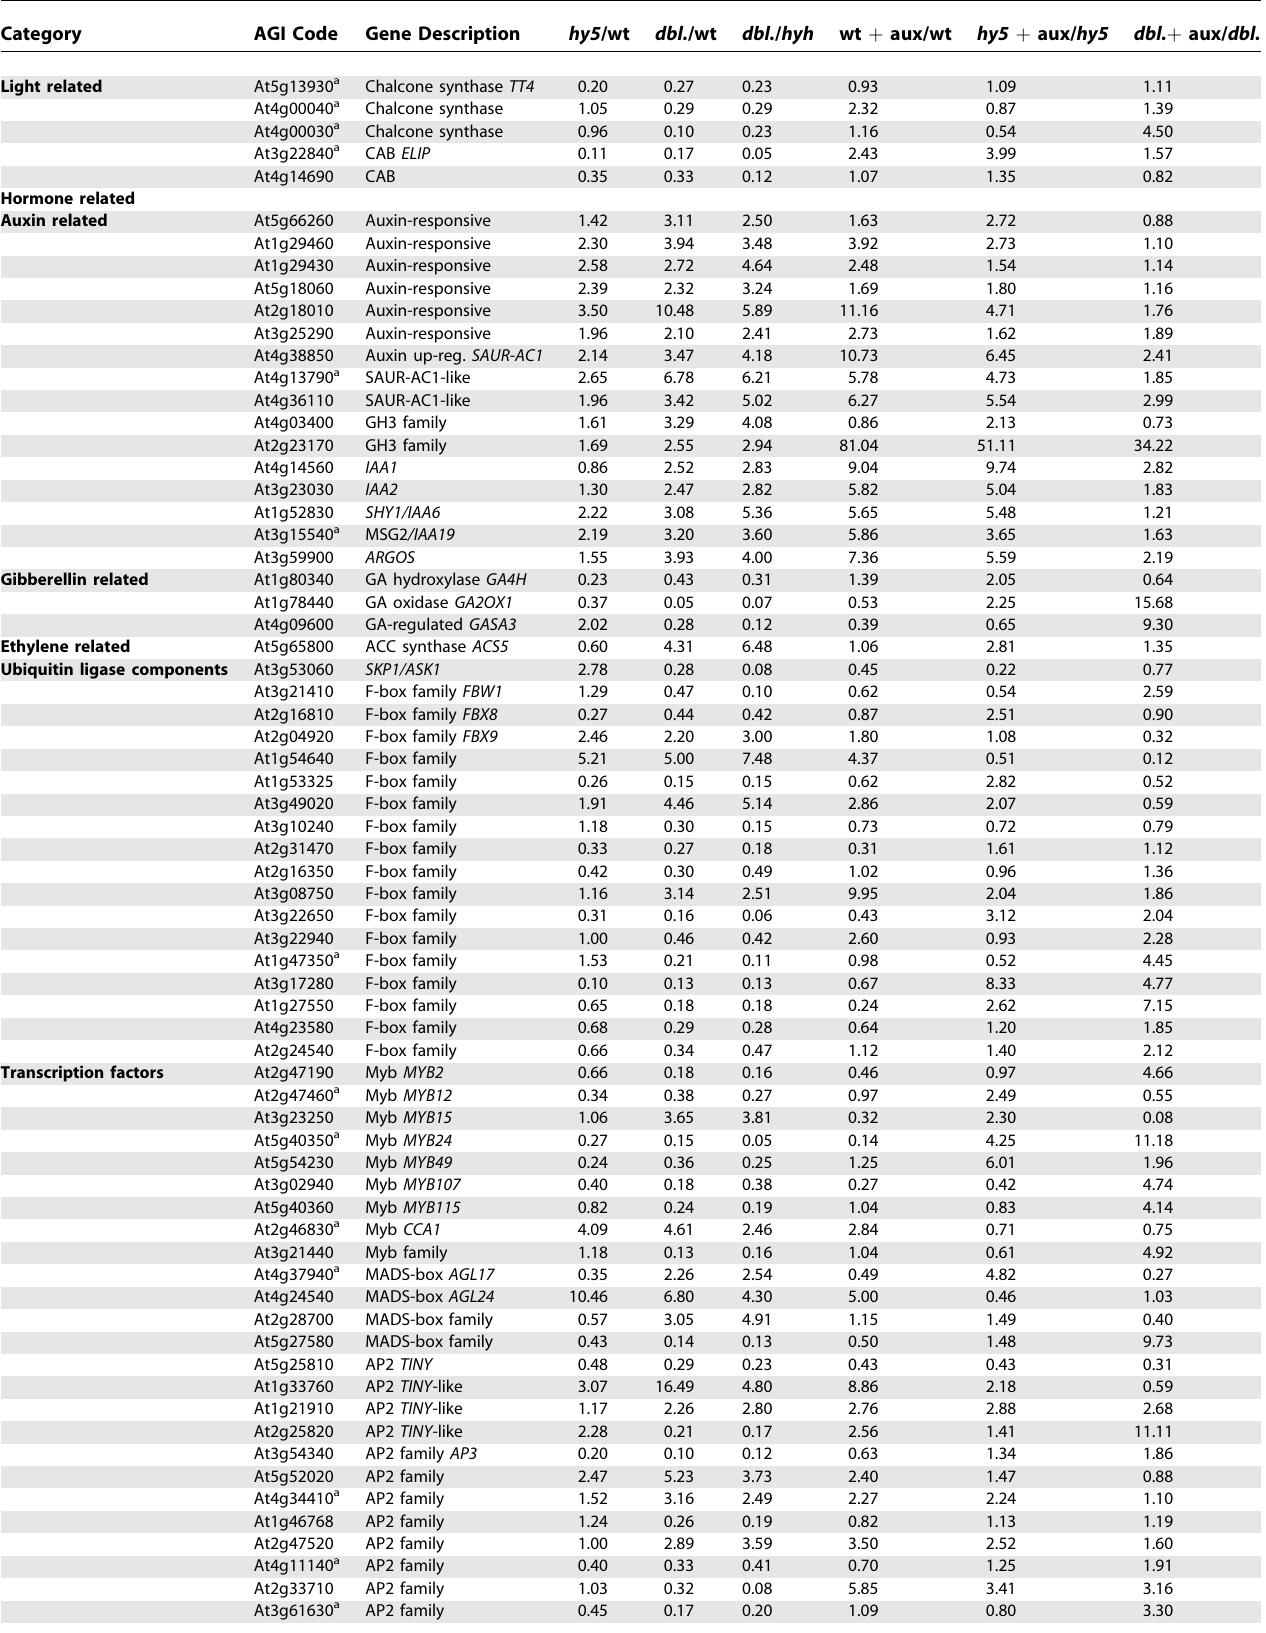
Table 1. List of Selected Genes Consistently Misregulated in hy5 hyh Double Mutants, Ordered According to Functional Classification